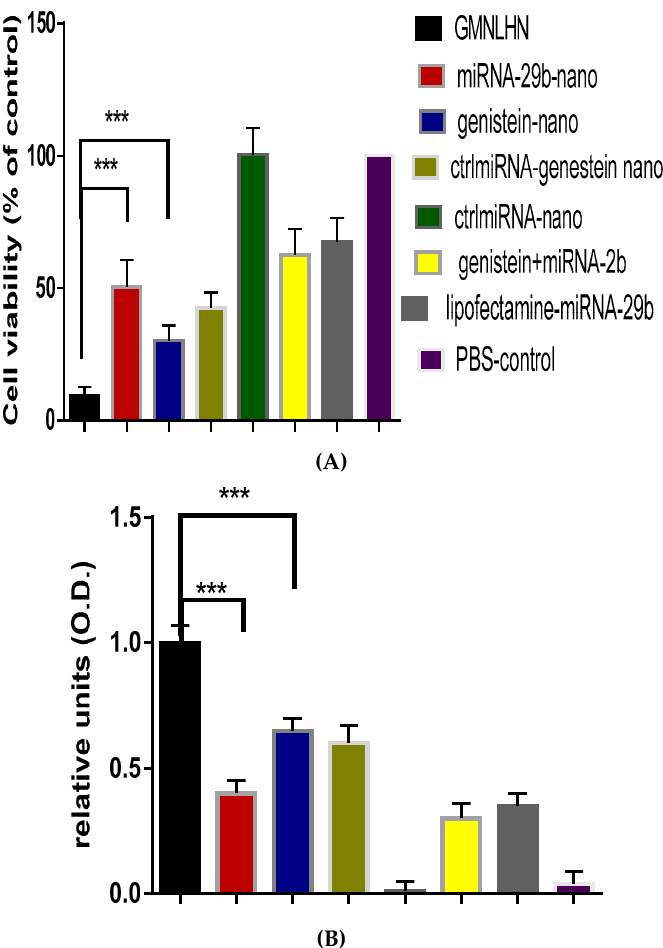
Figure 4. Antiproliferative effect and apoptosis. ( A ) MTT assay showing the antiproliferative effect of GMLHN, B ) Initiation of apoptosis in A549 cells as measured by cell death detection ELISA. p ≤ 0.001, n = 3. miRNA-29b-nano = miRNA-29b-loaded nanoparticles; genistein-nano = genistein-loaded nanoparticles; ctrlmiRNA-nano = controlmiRNA-loaded nanoparticles; genistein + miRNA-29b = physical mixture of genistein and